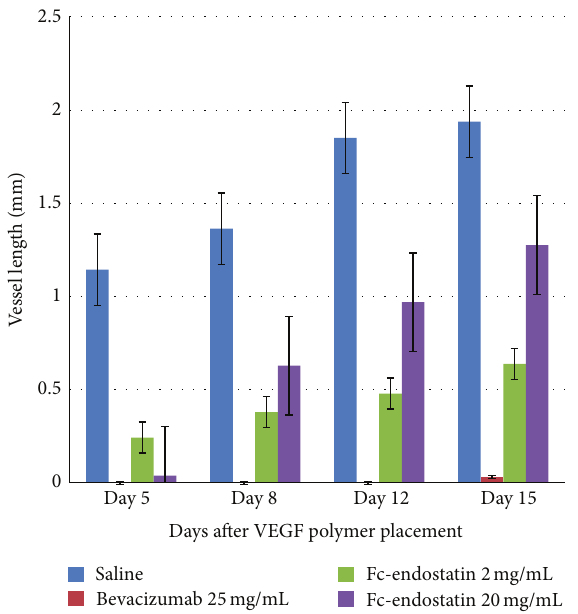
Figure 3: Inhibition of human vascular endothelial growth factor- (VEGF-) induced corneal neovascularization in rabbit. Mean vessel length ± standard error of the mean (SEM) of new vessels in control and treatment groups (BV: bevacizumab; FcE: Fc-endostatin).